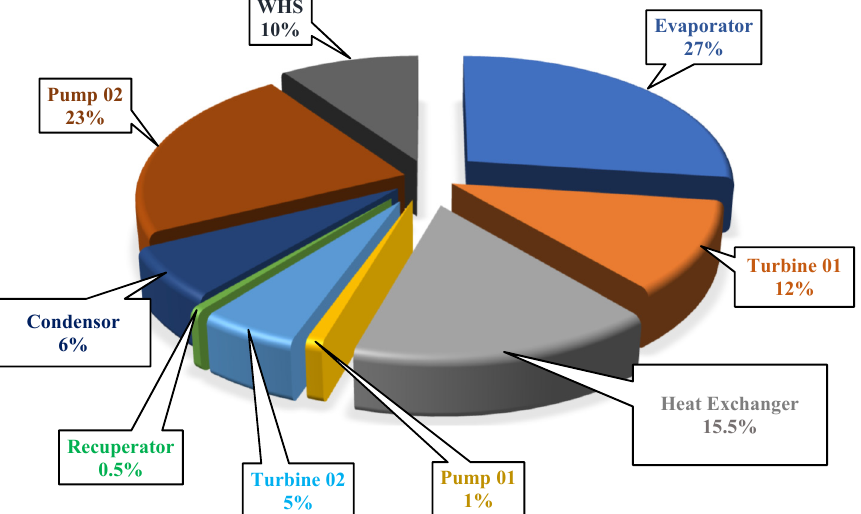
Figure 10. Percentage of exergy destruction in individual components at 350 °C heat source temperature in August.